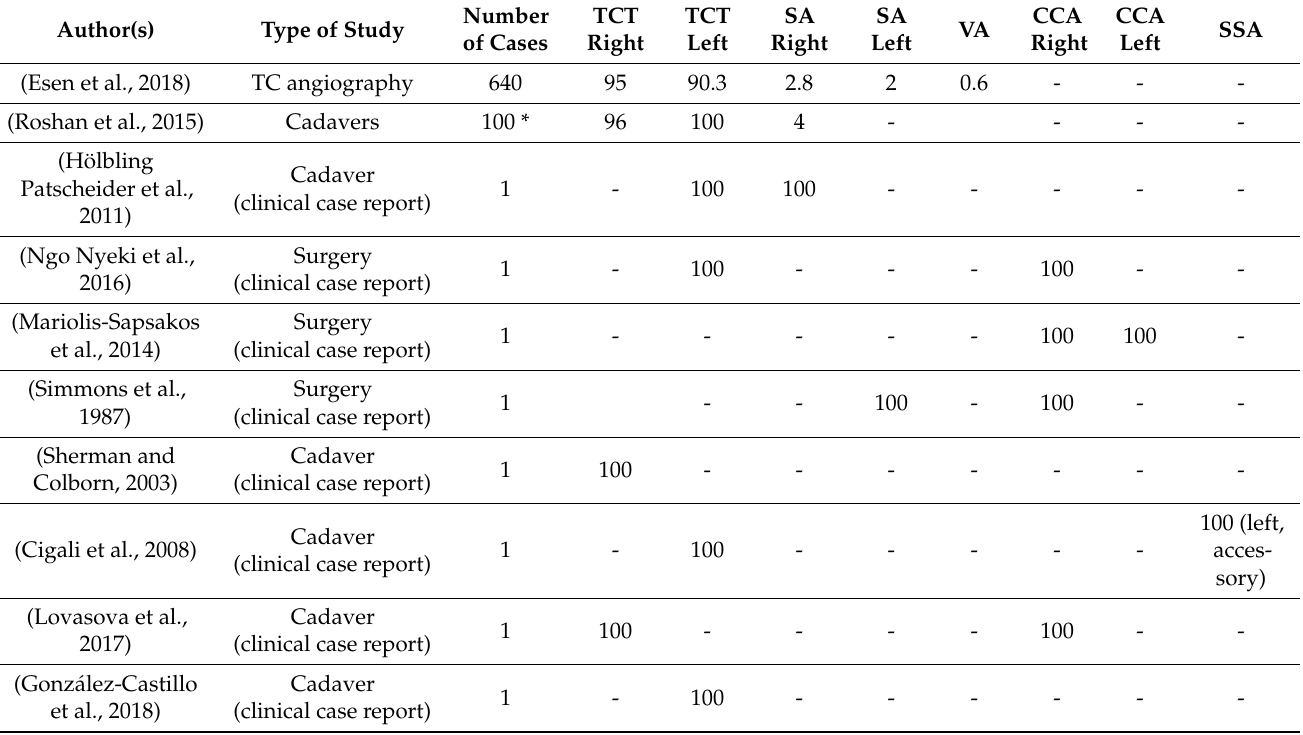
Table 5. Available data concerning the ITA